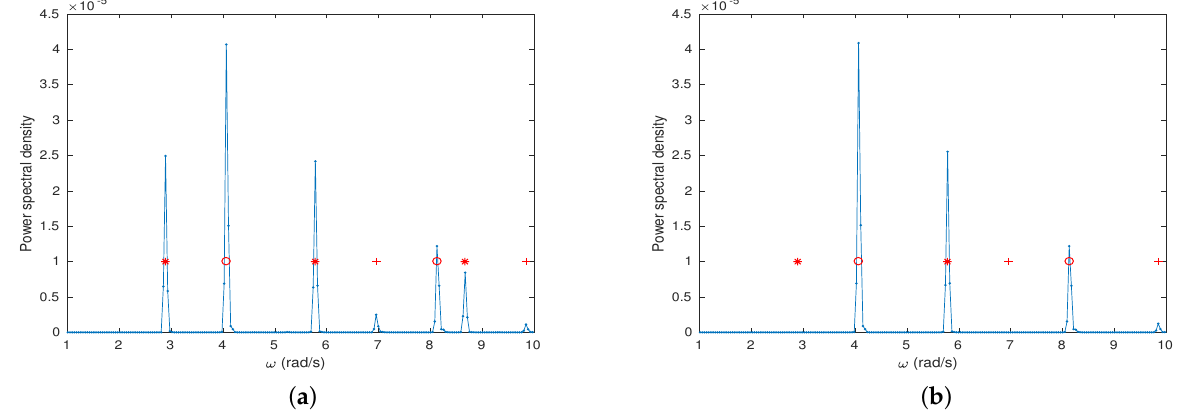
Figure 16. The frequency spectrum of coupled surge − sway − roll − pitch − yaw excitations cases at the tank corner under under different excitation frequencies. ( a ) corner A: ( l /2, b /2); ( b ) corner B: ( − l /2, b